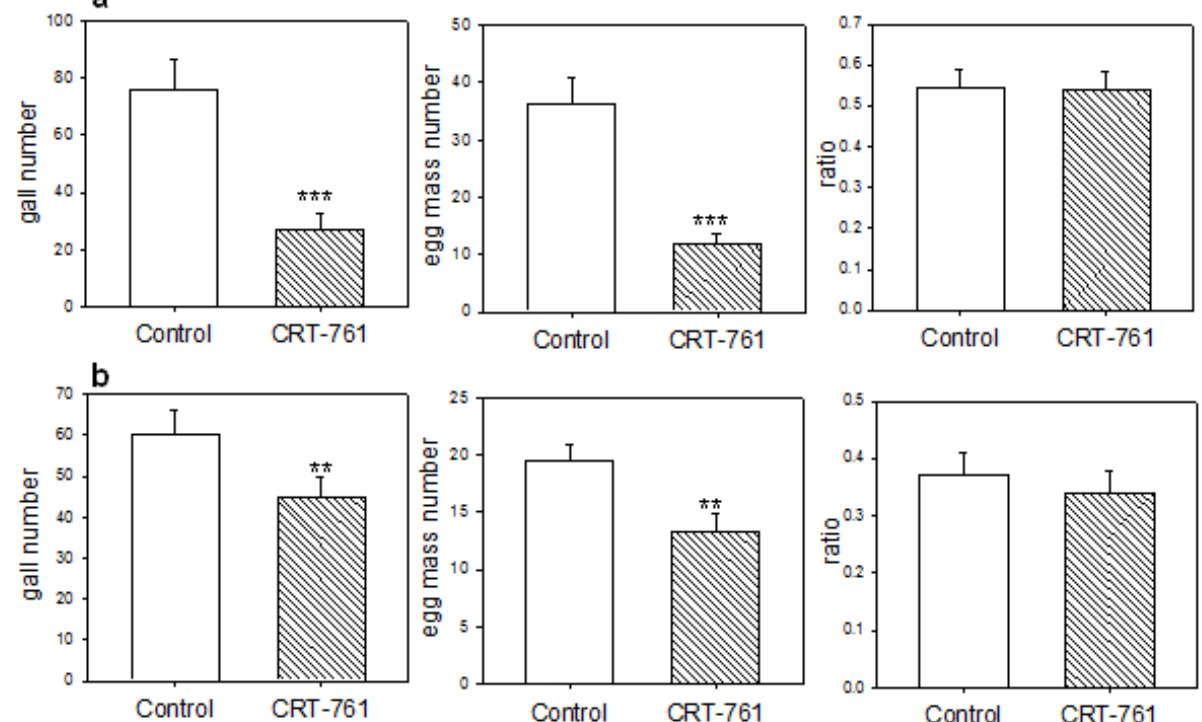
Figure 7. Mi-CRT silencing affects nematode pathogenicity. J2s were soaked for 1 hour in the presence of control siRNA or siRNA CRT-761 in water, washed and maintained for an additional 16 hours in water before infection of tomato plants. The ability of the nematodes to establish into the root and to complete their life cycle was analyzed by counting galls and egg masses 6 weeks after infection ( a ) Similar results were obtained in an independent biological duplicate; ( b ) Error bars: standard error of the mean (SEM). Statistical analyses p -Value codes are p -Value = 0.0001 (cid:181)(cid:13)(cid:13)(cid:13)(cid:182)(cid:15)(cid:3) p -Value = 0.001 (cid:181) ** (cid:182)